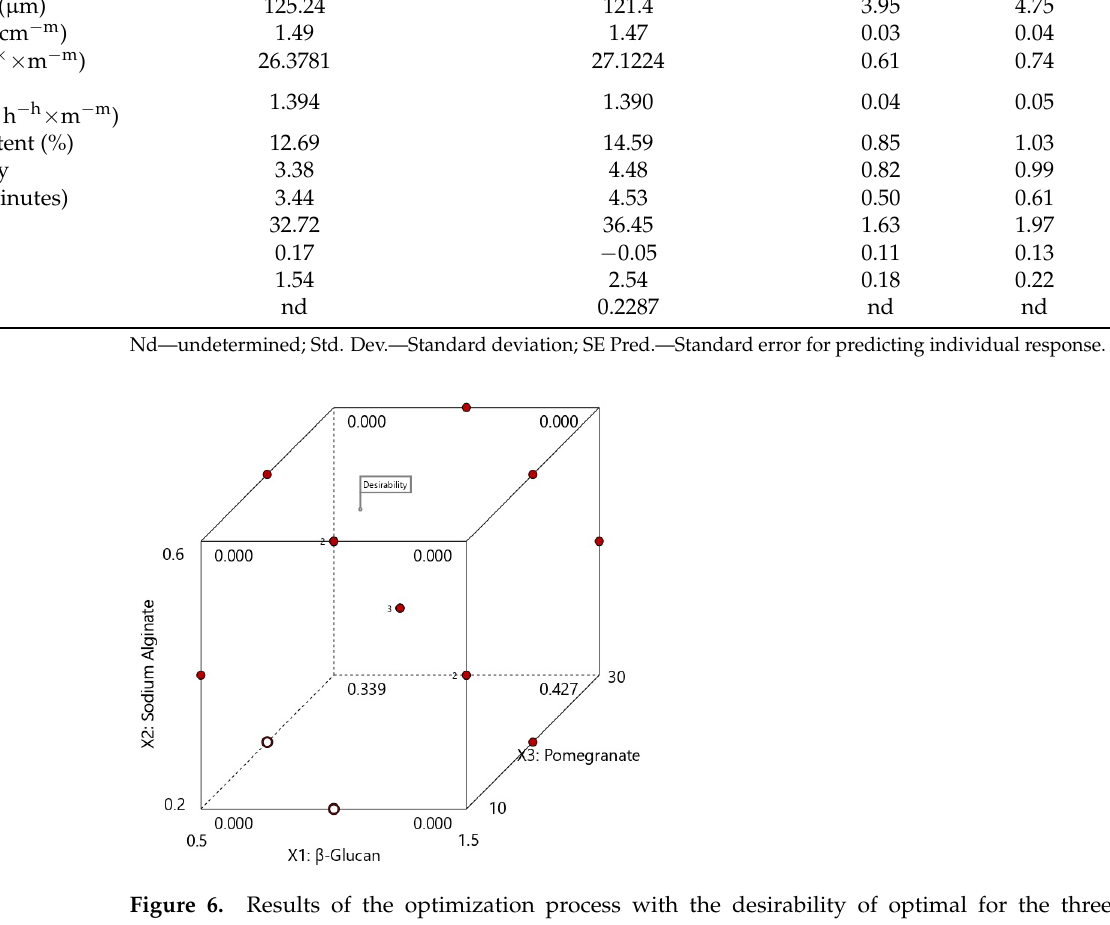
Table 7. Predicted vs. actual values of the optimal film sample.